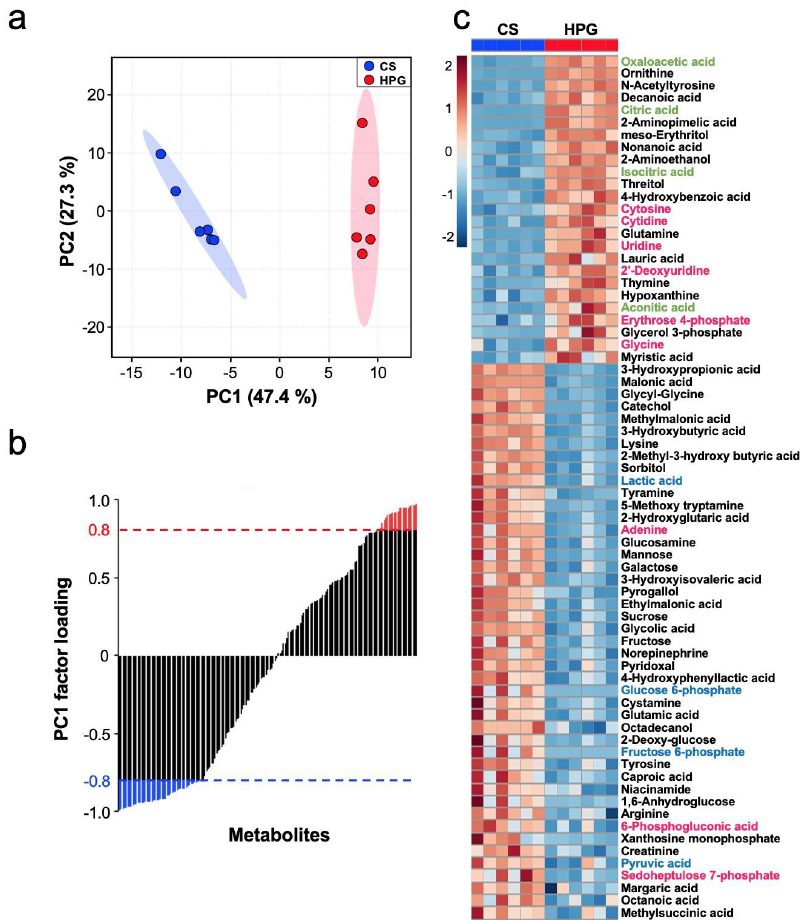
Figure 3. Metabolite profiling of hearts preserved using the cold storage (CS) method and high-pressure gas (HPG) method. ( a ) Principal components analysis (PCA) score plot. Blue and red circles represent 95% confidence interval of CS and HPG, respectively. ( b ) Factor loading plot for PC1. A total of 70 statistically significant metabolites were selected with an absolute value of 0.8 of PC1 factor loading. Blue and red dotted lines show the significantly negative and positive levels, respectively. ( c ) A heat map of 70 statistically significant metabolites in the CS and HPG groups. Red, green, and blue letters show metabolites of the pentose phosphate pathway and nucleic acid, tricarboxylic acid (TCA) cycle, and glycolysis, respectively. The color scale from blue to red indicates low to high amount of metabolites between CS and